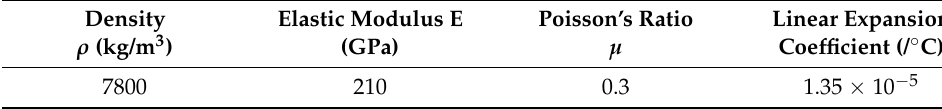
Table 2. The fracture toughness of